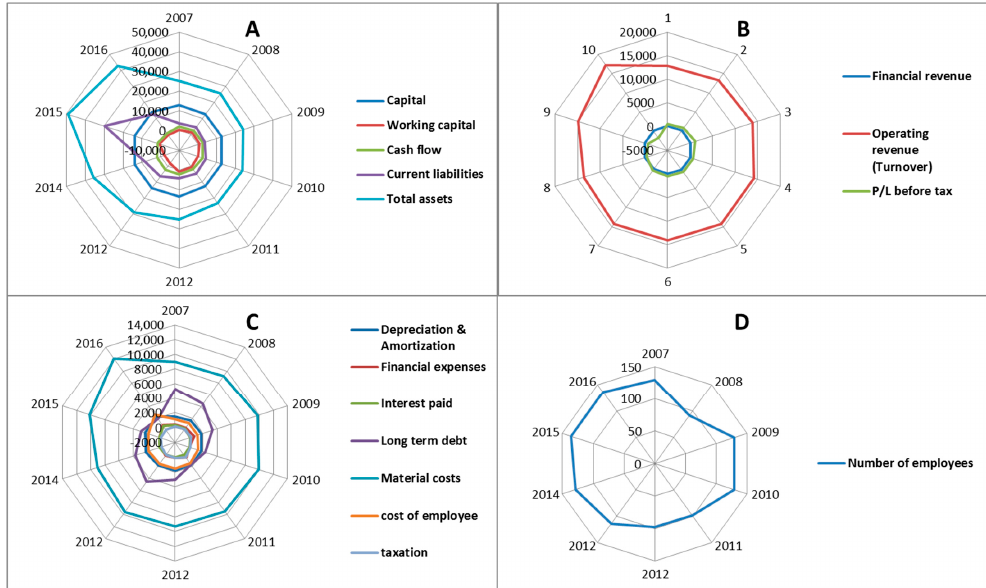
Figure A4. Historical financial results of the companies: End Market segment of the coal value chain. ( A )—financial performance; ( B )—result of the activity; ( C )—costs; ( D )—employment. For the End Market, the historical trend of the four variables show all a similar a quite constant trend all through the time horizon of the analysis. The companies belonging to this segment of the coal value chain seem to have experienced a more stable operation, in terms of performance and presence in the market during the previous 10 years. Table A1. The list of companies included in the financial analysis.